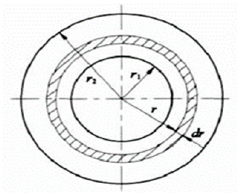
Figure 2. Friction surface of the pressure plate.